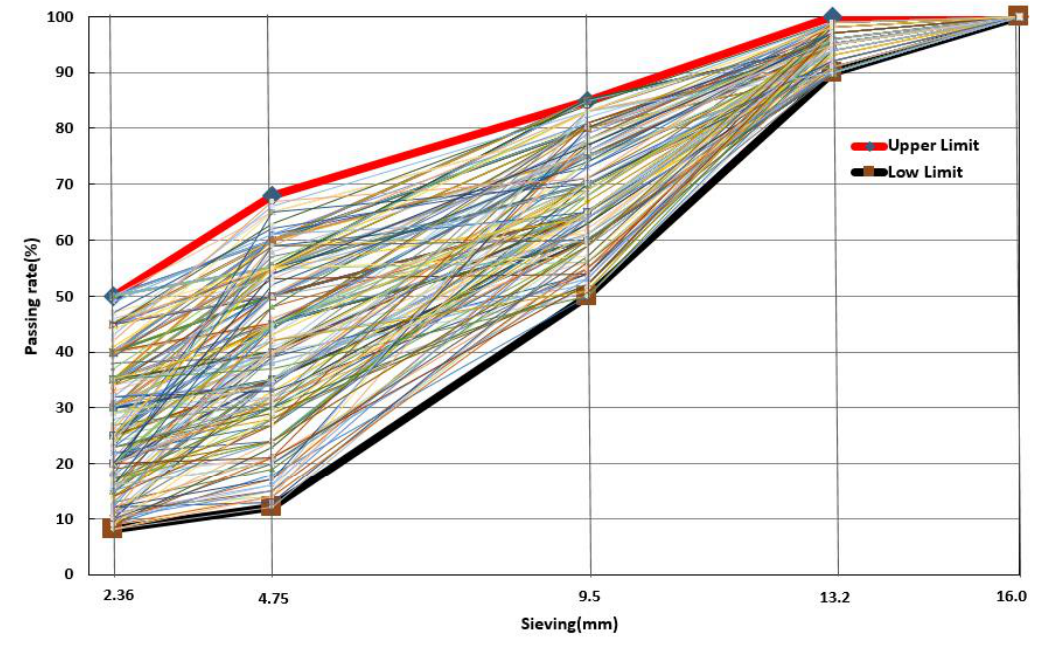
Figure 1. 200 coarse aggregate proportions of Gradation-13.